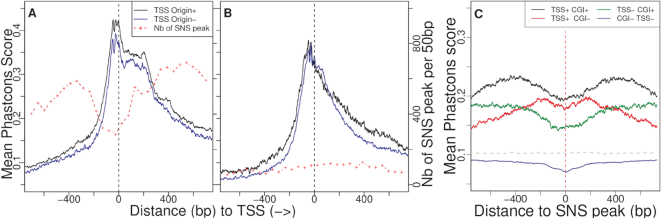
Profile of sequence conservation around TSSs and replication origins. (A, B) Human TSSs. Black: TSSs <750 bp away from an origin. Blue: TSSs that are not associated with an origin. The red dotted line presents the number of SNS peaks found around all TSSs (smoothed over 50 bp windows). All TSSs are oriented 5′ → 3′ relative to the transcription unit. (A) TSS associated with a CGI (B) TSS not associated to a CGI. (C) Average PhastCons scores calculated in a 1400 bp region centred on human SNS Peaks, depending on the origin association with TSSs and CGIs. The dashed line presents the genome-wide phastCons score average.